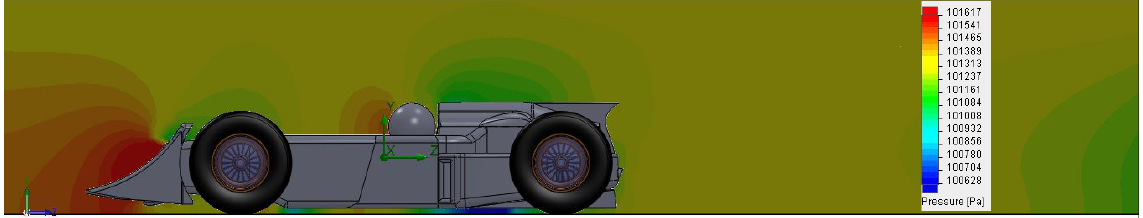
Figure 10. Air flow pressure distribution on optimized prototype (lateral view).